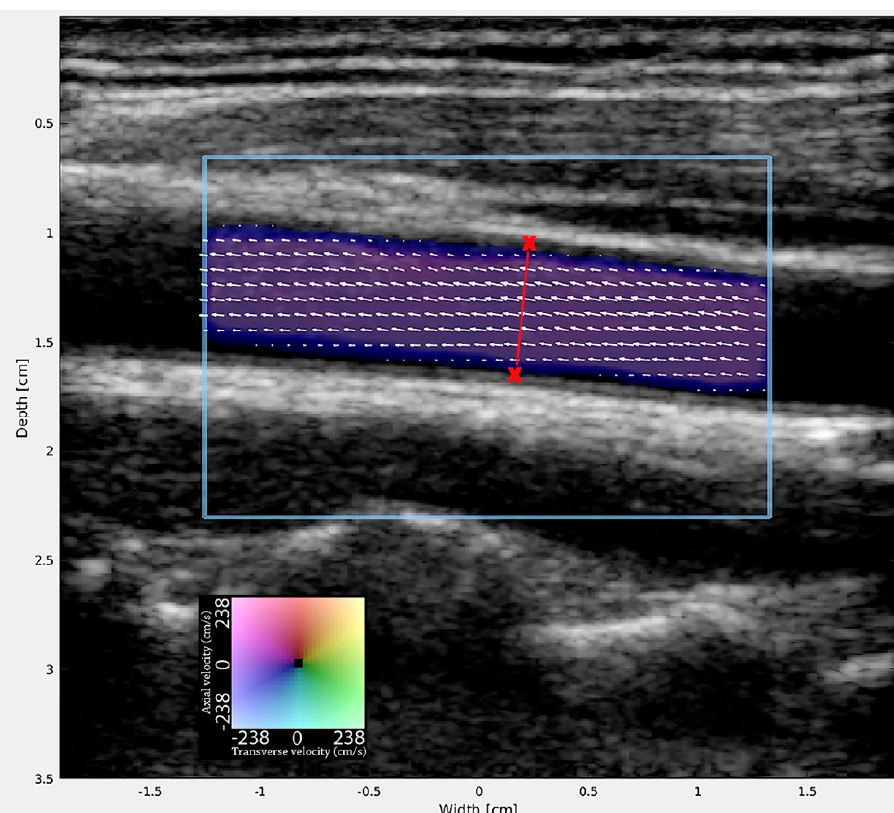
Figure 1. The VFI estimation setup in the CCA. Volume flow was found by integrating the VFI data along a line perpendicular to the long axis of the CCA. The line was drawn between two markers set by the operator at the intima of the vessel. The direction and velocity magnitude of the blood flow are given by the color wheel and indicated by the superimposed vector arrows.